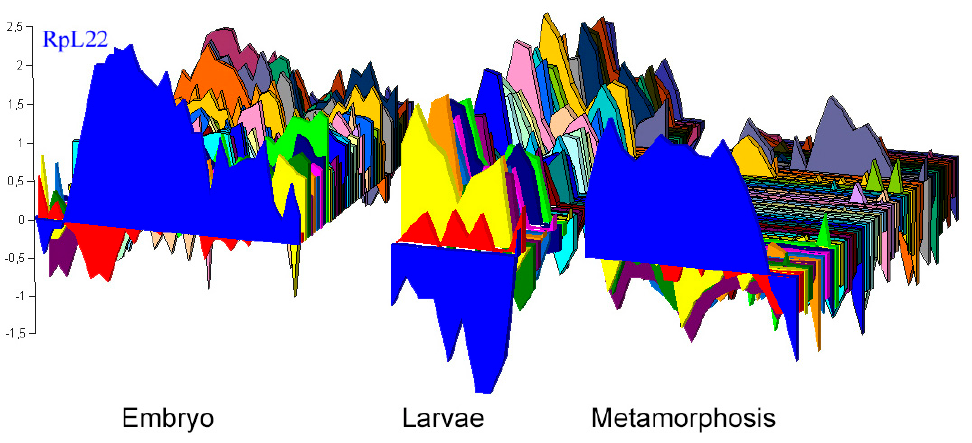
Figure 5. Comparison of the expression profile of RpL22 (in blue) with the other ribosomal proteins during the development of Drosophila melanogaster . Microarray data of ribosomal D. melanogaster gene expression during development was downloaded from the FLYMINE database [49] (available at: https://www.flymine.org/flymine; last accessed 15/12/2021). These data were used to construct the graph. Y axis: fold change. Reference sample is a pooled mRNA representing all stages of the life cycle as reported in Arbeitman et al. [48].